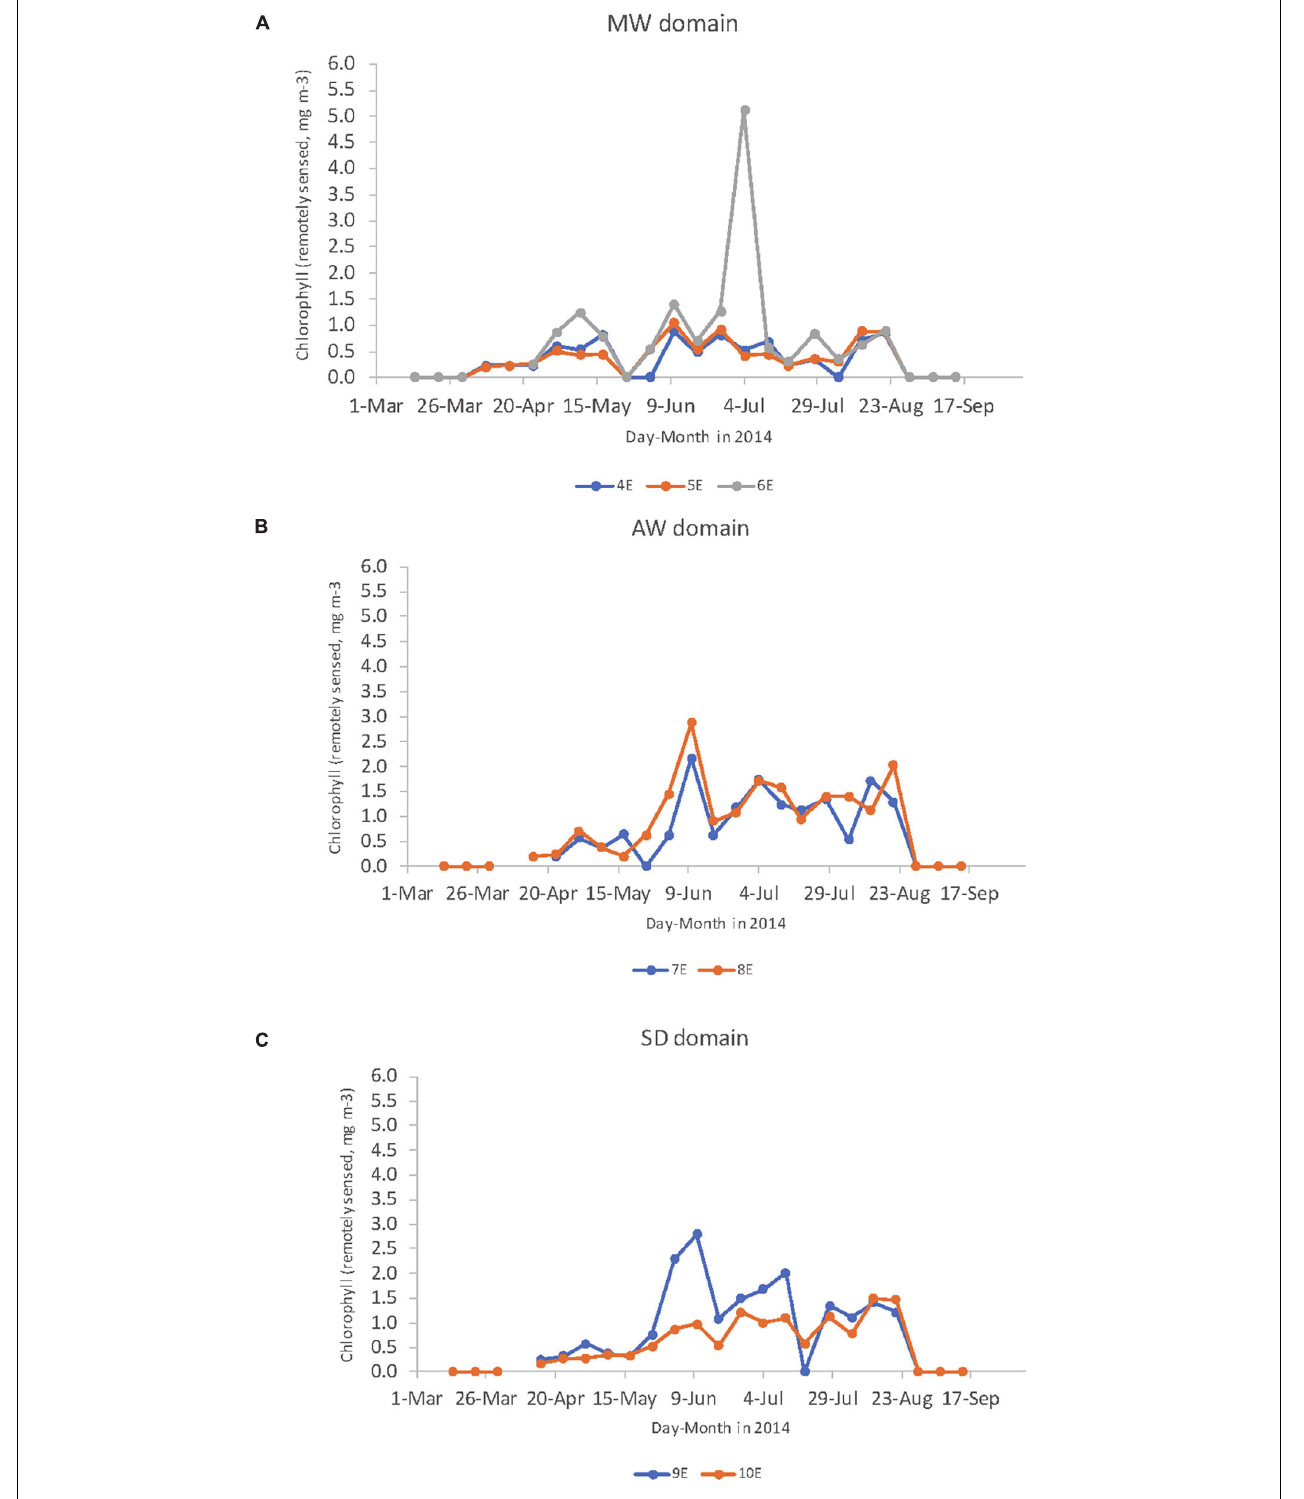
FIGURE 13 | The seasonal variability of the maximum value of remotely sensed chlorophyll a (mg m − 3 ) in the area between 79.75 and 78.75 ◦ N from 4 to 10 ◦ E divided in the: (A) meltwater influenced domain (MWD), (B) the Atlantic water domain (AWD), and (C) in the shelf domain (SD) from 4th of February to 12th of October in 2014. Values are Level 3, 8-day binned, 9 × 9 km resolution arrays from the Moderate Resolution Imaging Spectroradiometer (MODIS) onboard Aqua spacecraft downloaded from NASA Goddard Space Flight Center, Ocean Ecology Laboratory, Ocean Biology Processing Group.